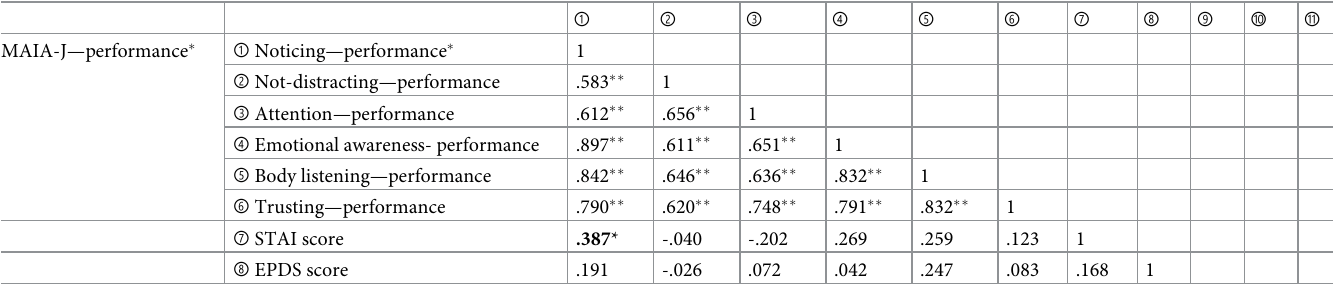
From ① — ⑥ , data are the difference between MAIA subscale and heartbeat counting task performance. � performance = heartbeat counting task